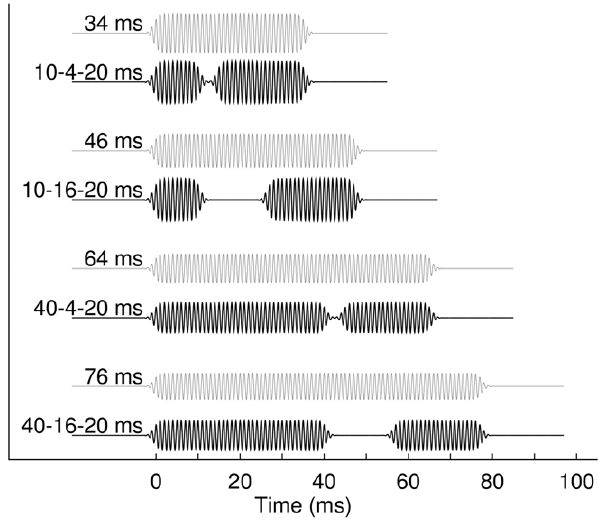
Figure 1. Waveforms of the auditory stimuli. The sounds of 34, 46, 64, and 76 ms total duration, respectively, were either continuous tones or contained a temporal gap. The gap lengths were 4 or 16 ms, the length of the leading marker 10 or 40 ms, and the trailing marker was always 20 ms long. The stimulus amplitudes were adjusted for equal